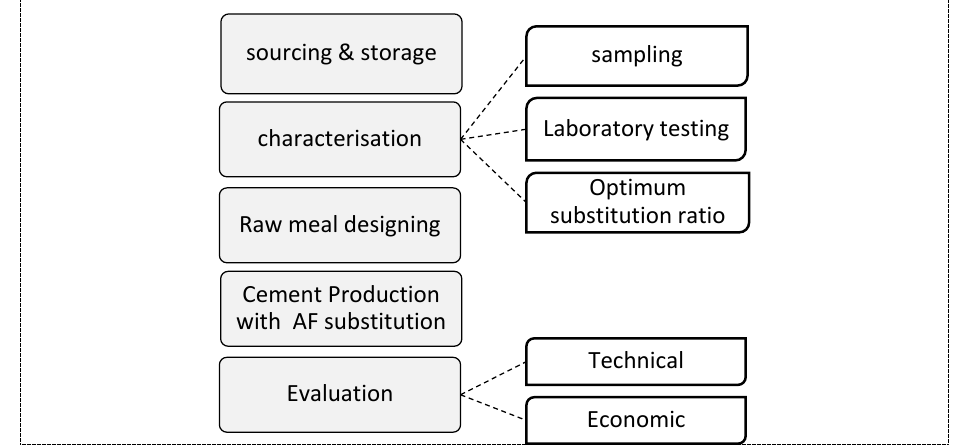
Figure 3. Methodology for the case study.